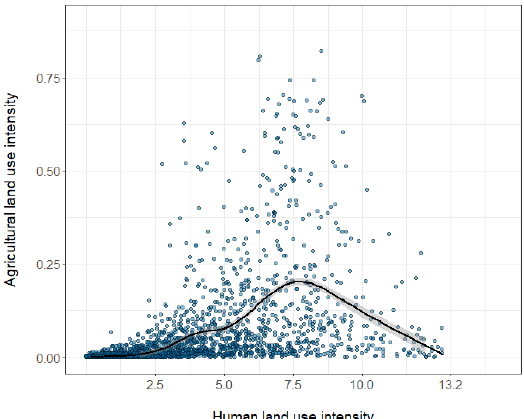
Figure 4. The relationship between the agricultural land use intensity index (AgI) and LUI. Each dot corresponds to one observation unit (spatial landscape unit), derived from a sample of 396 observation units throughout Norway. The solid line represents a LOESS smoother and the grey band around the line shows the uncertainty in the linear fit of the trend line with a 95% confidence level.